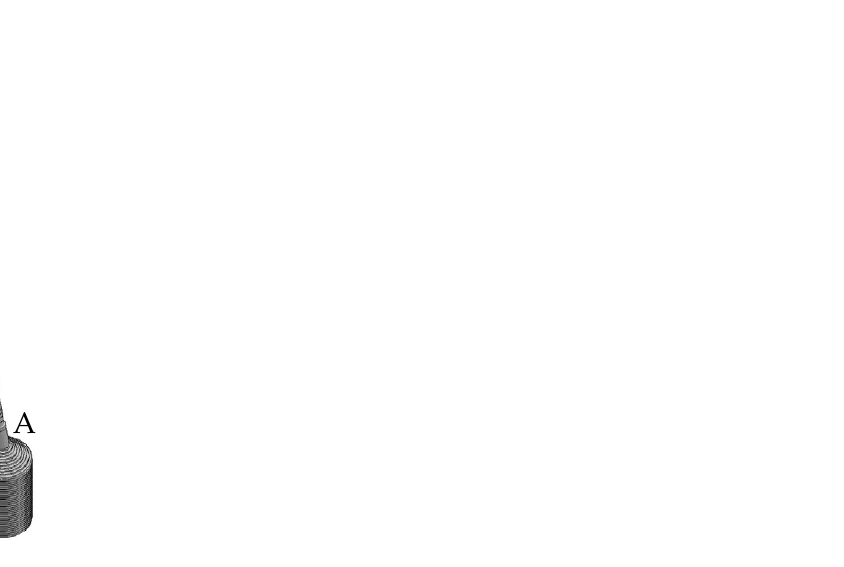
Figure 9. A 15 MW OWT jacket support structure with three-leg suction piles in 70 m deep water (suction pile diameter = 22 m, length = 30 m; p-y, t-z, and Q-z nonlinear springs for soil–structure interaction analysis).